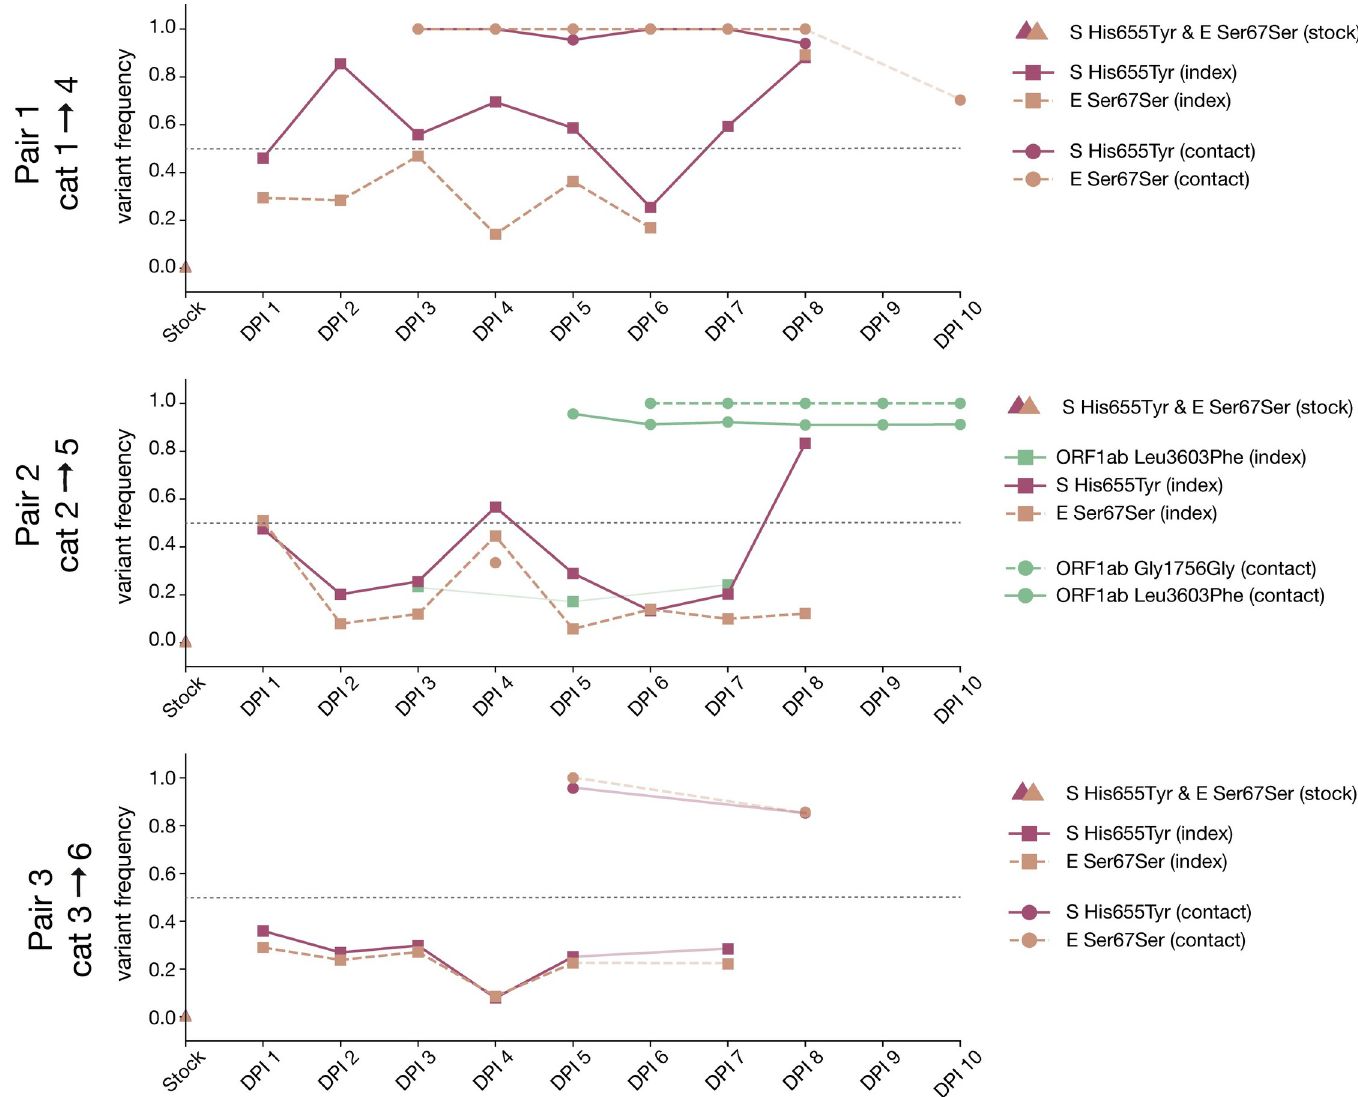
Fig 3. Frequency of iSNVs over time in each index and contact cat. The frequency of iSNVs discussed in the results over time in all six cats are shown. All iSNVs over time are shown in S2 Fig and all indels over time are shown in S3 Fig . Each variant is colored by gene location. Nonsynonymous variants are plotted with solid lines and synonymous variants are plotted with dashed lines. Variants detected in index cats are denoted with squares and variants detected in contact cats are denoted with circles. Timepoints with viral loads too low to yield high quality sequences are shown by the gaps in data, but iSNVs are connected across these gaps using light lines for readability (i.e. cat 1 day 9). The dotted line at 50% frequency represents the consensus